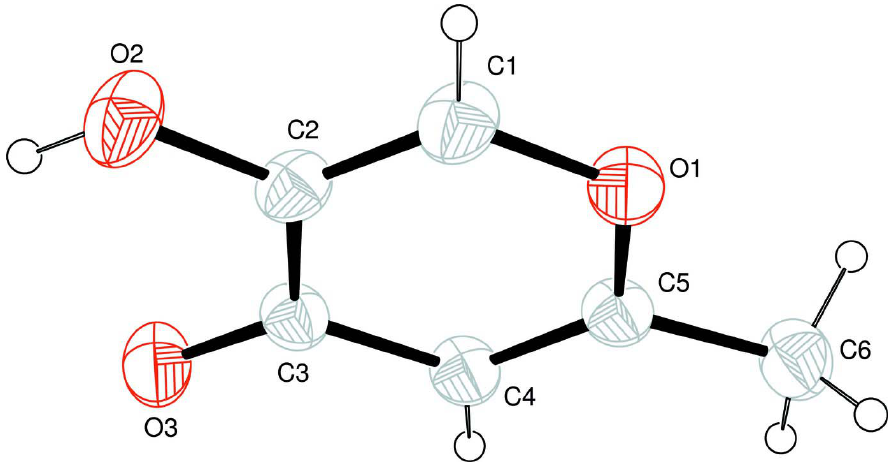
Figure 1 ORTEP drawing of the title compound, with the atom numbering scheme. The thermal ellipsoids are drawn at the 30% probability level. H atoms are shown by small circles of arbitrary radii.